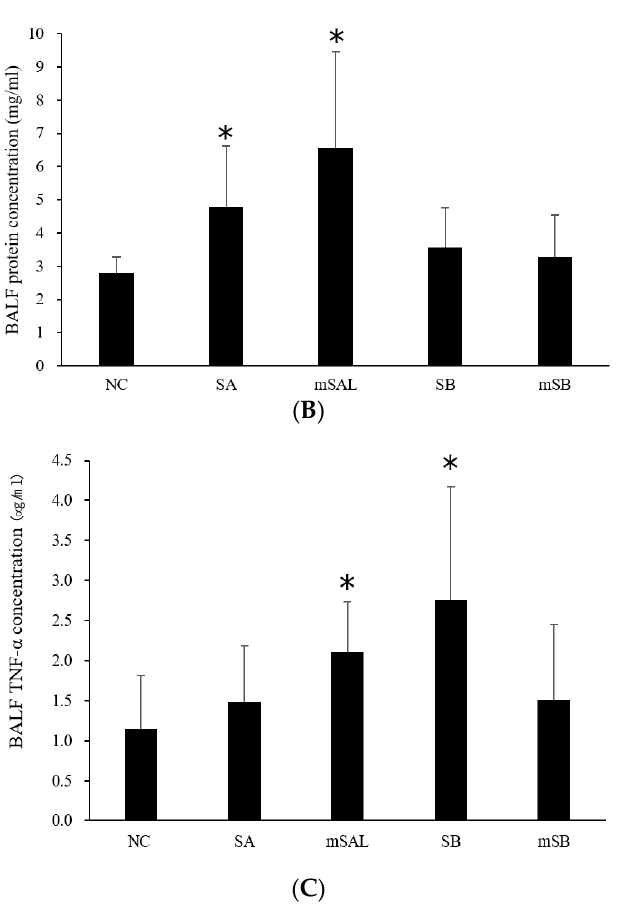
Figure 4. Relative lung weight, BALF protein concentration, and BALF TNF- α concentration of rats